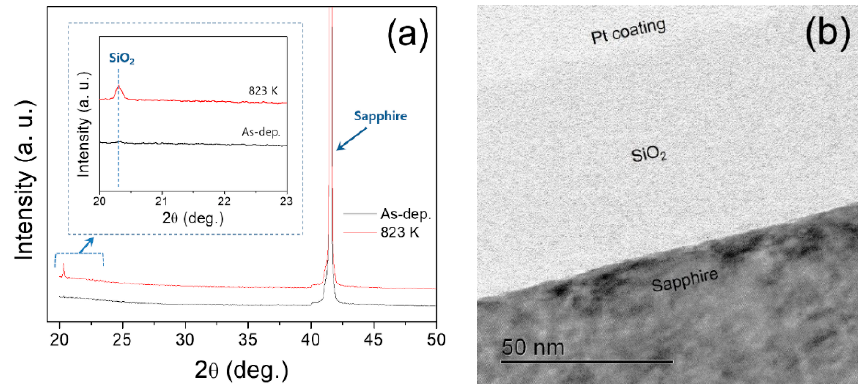
Figure 1. ( a ) XRD patterns of the as-deposited and oxidized Si/sapphire films; ( b ) cross-sectional TEM image of the Si/sapphire film oxidized at 823 K.